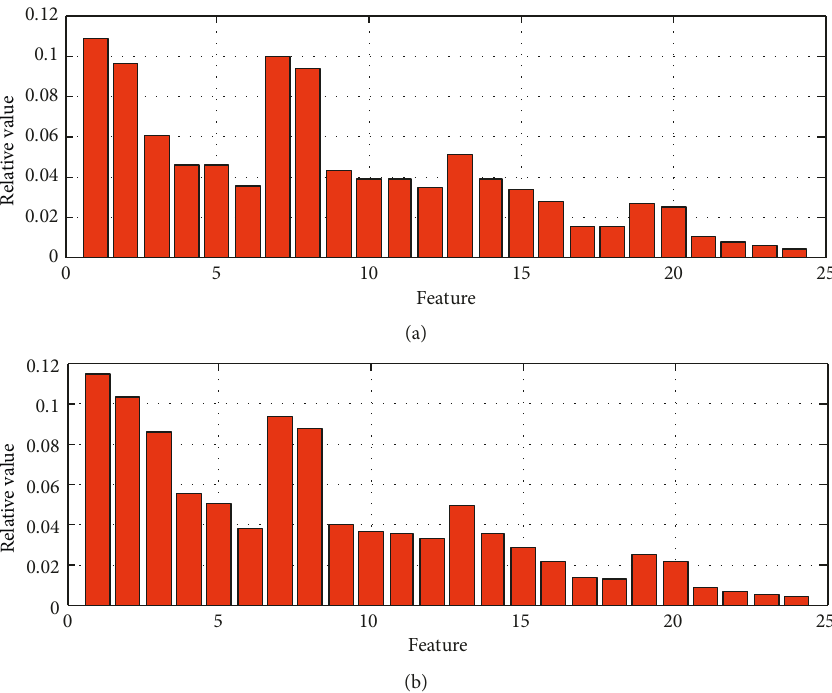
Figure 4: The features of two samples representing outer race fault and ball fault, respectively, in a set of samples based on LSS in LSS-BGSA- RVM3. (a) The features of the sample representing outer race fault, and (b) the features of the sample representing ball fault. Table 2: The comparison of the diagnosis accuracy of bearing between LSS-BGSA-RVM and LS-RVM. The number of the The number of the testing samples Classifier Diagnosis accuracy testing samples with correct diagnosis